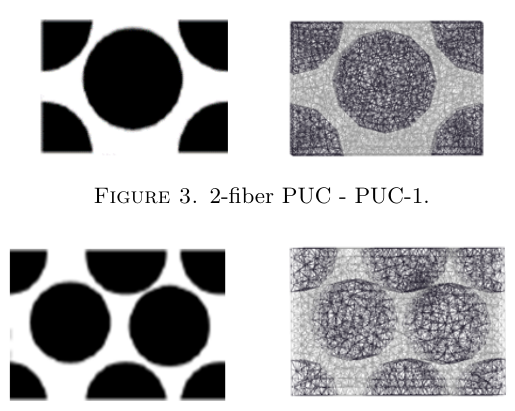
Figure 4. 4-fiber PUC - PUC-2.